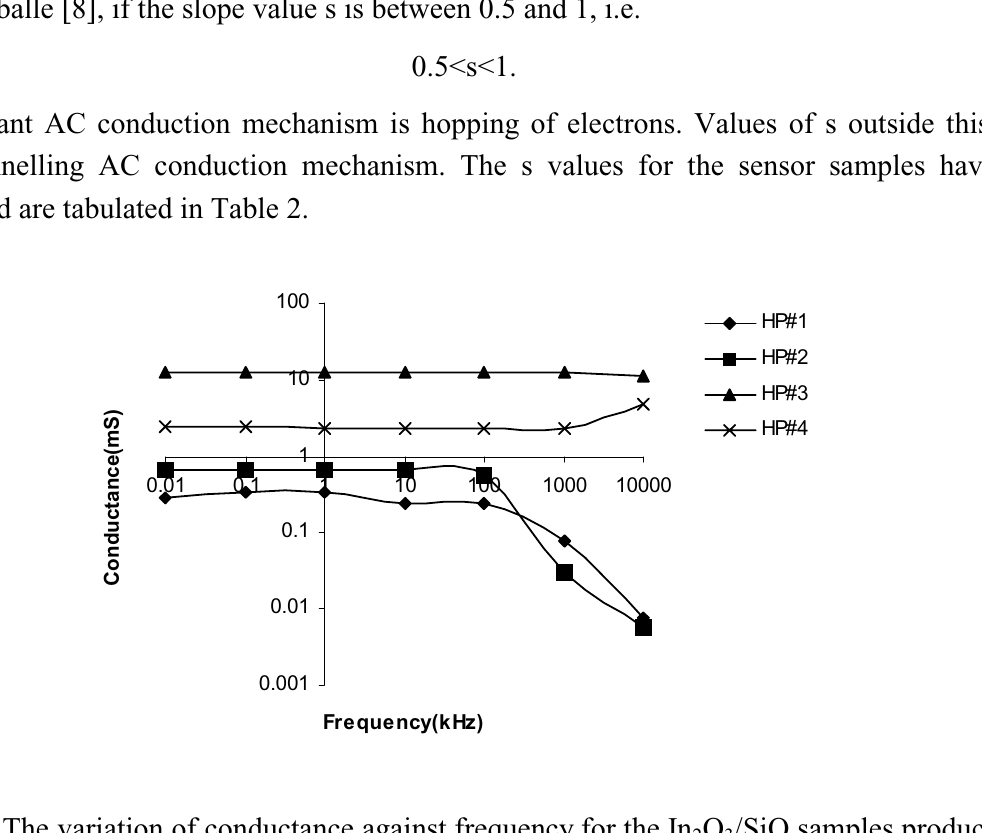
O /SiO samples produced 2 3